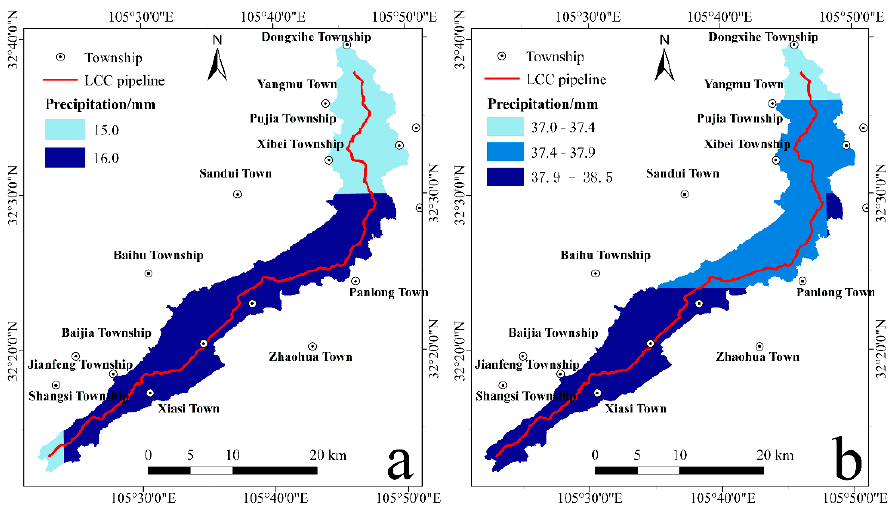
Figure 11. The spatial distribution characteristics of 10 min rainfall ( a ) and 1 h rainfall ( b ) in the study area.